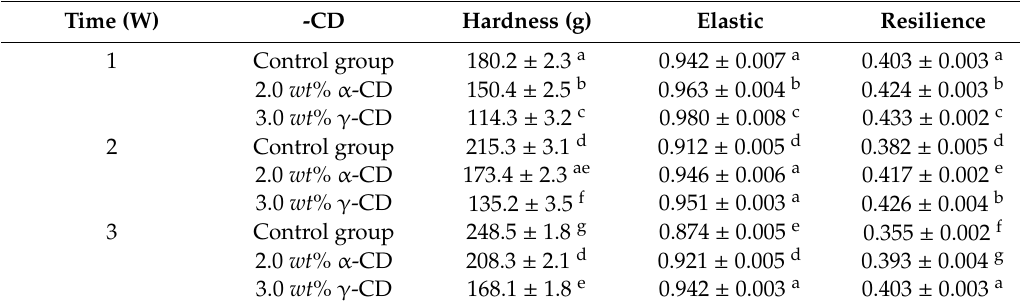
Table 3. E ff ects of the addition of 2.0 wt% α -CD and 3.0 wt% γ -CD on the texture of prebaked bread samples that had been frozen for 1, 2, or 3